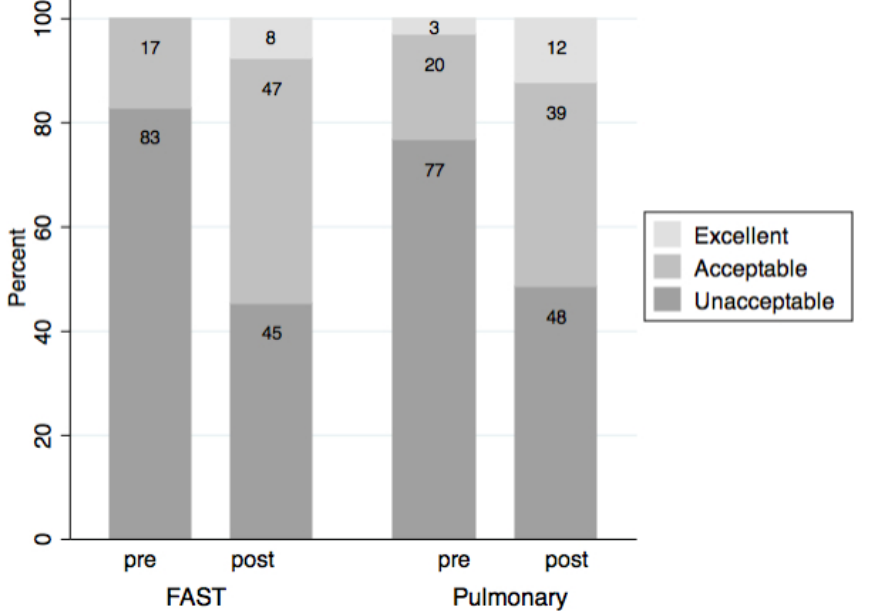
Figure 2. Percent improvement in Clinical Skills Image Acquisition between pre- and post-Ultrafest for FAST (Focused Assessment of Sonography for Trauma) and Pulmonary Ultrasound exams. N=16 for each ultrasound